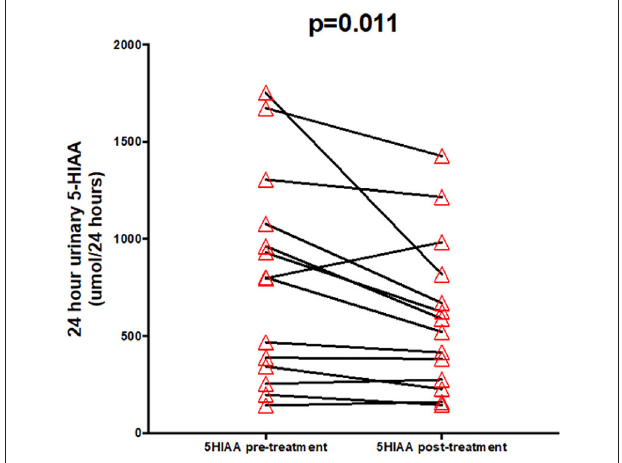
FIGURE 4 | Urinary 5-HIAA pre- and post-treatment.